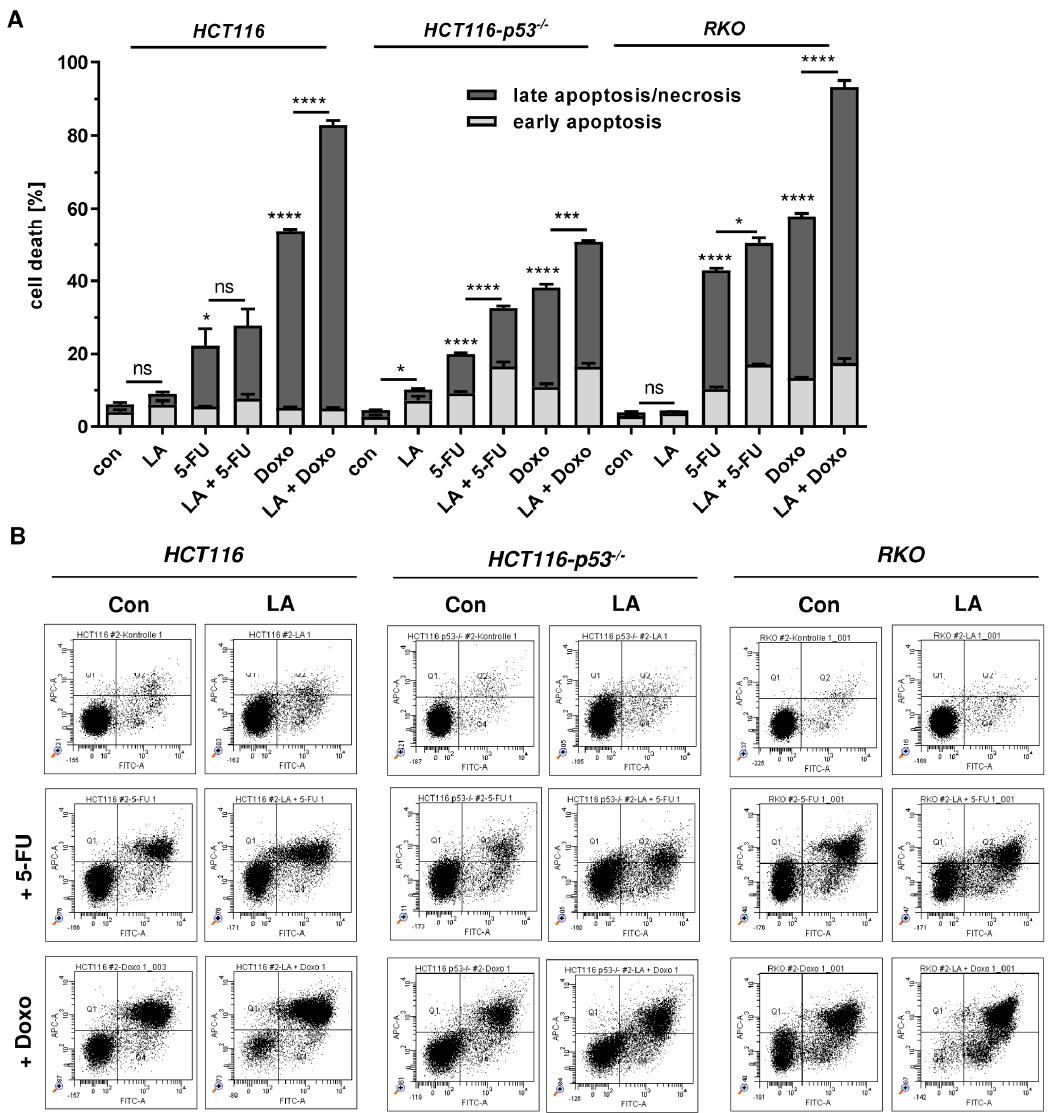
Figure 9. LA potentiates cell death induction in CRC upon treatment with the anticancer drugs Doxo and 5-FU. ( A ) Cells were pre-treated with LA for 48 h (250 µ M for HCT116 and HCT116-p53 − / − ; 100 µ M for RKO), then supplemented with either Doxo (1 µ M for HCT116 and RKO; 5 µ M for HCT116-p53 − / − ) or 5-FU (5 µ M for HCT116; 20 µ M for HCT116-p53 − / − ; 10 µ M for RKO) and treated for another 72 h. After 120 h, cells were collected for cell death measurements and subjected to AnnexinV / PI staining followed by flow cytometry. Data is presented as mean + SEM (n ≥ 3). Ns: p > 0.05; * p < 0.05; *** p < 0.001; **** p < 0.0001. ( B ) Representative dot plots for experiments shown in (A).